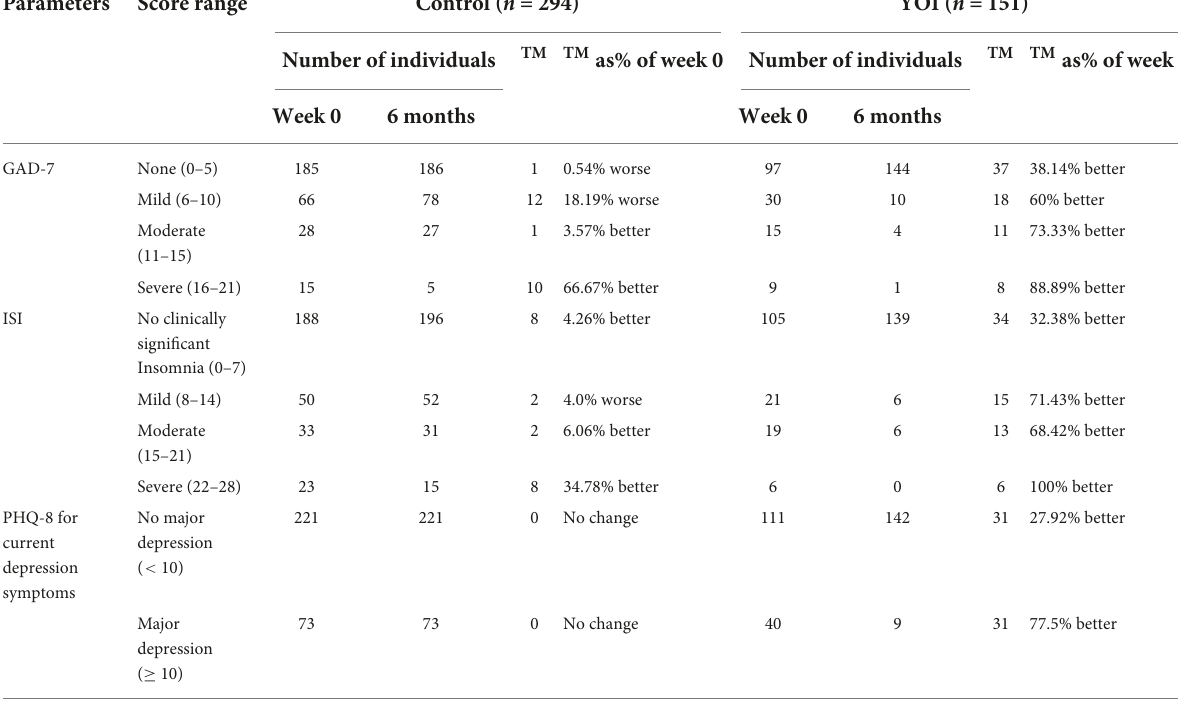
TABLE 5 Number of individuals in each of the score ranges of GAD, ISI and PHQ8 at week 0 and week 8 in controls (total n = 294) and test ( n = 151) groups.